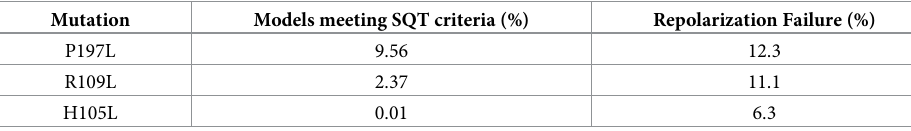
Table 3. Computational Results for GOF